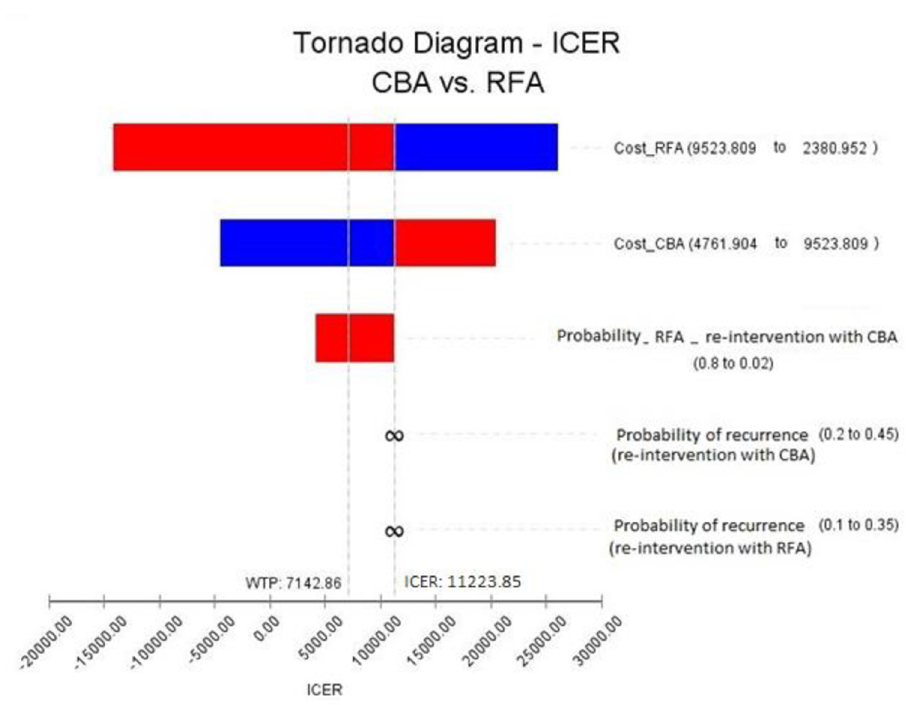
Fig 3. One way sensitivity analysis using Tornado